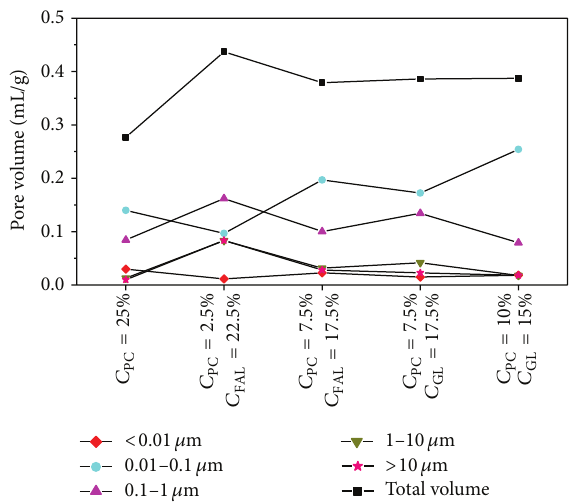
Figure 7: Pore size distribution classified by an order of magnitude of different proportion of stabilized